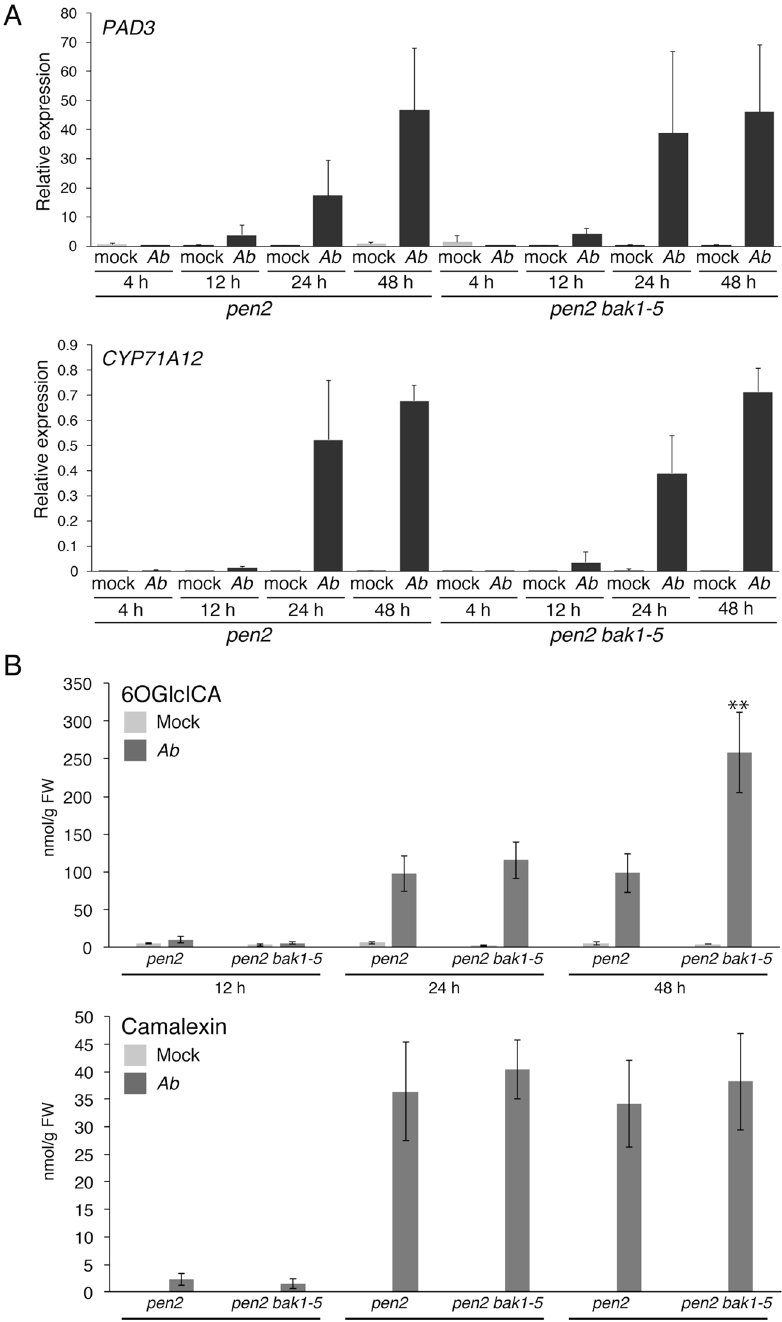
Figure 5. The bak1–5 mutation did not reduce the Ab -invasion triggered accumulation of 6-hydroxy-ICA and camalexin. ( A ) The Ab -invasion triggered activation of CYP71A12 and PAD3 expression in the pen2 bak1–5 mutant. Conidial suspensions (5 × 10 5 conidia/mL) of Ab were spray-inoculated onto 4–5-week-old plants. The samples were collected at 4, 12, 24, and 48 hpi. Each gene transcript was quantified by RT–qPCR using the gene-specific primers listed in Supplementary Table S2. Values were normalized to the expression level of UBC21 . The statistical comparison between Ab -treated pen2 and Ab -treated pen2 bak1-5 at same time point samples was conducted using two-tailed Student’s t tests and did not show significant differences. ( B ) The Ab invasion-triggered accumulations of 6-hydroxy-ICA (6OGlcICA) and camalexin were not canceled by the bak1–5 mutation. Conidial suspensions (5 × 10 5 conidia/mL) of Ab were spray-inoculated onto the tested mutant lines. The means of metabolites (nmol/g FW) and SDs from four biological independent samples are shown in the graph. The statistical comparison between pen2 and pen2 bak1-5 at same timepoint was conducted using two-tailed Student’s t tests (** P <